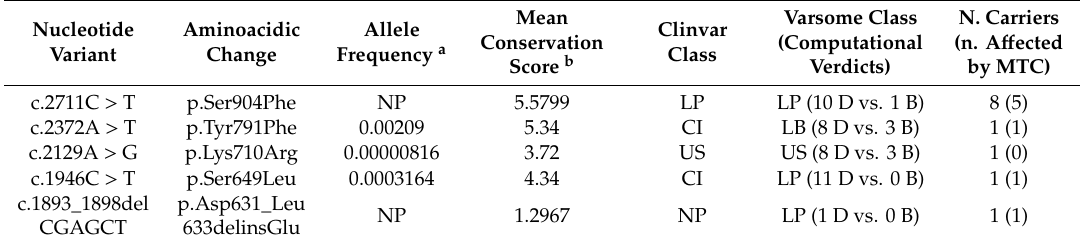
Table 3. Frequency and predictions of unclassified variants